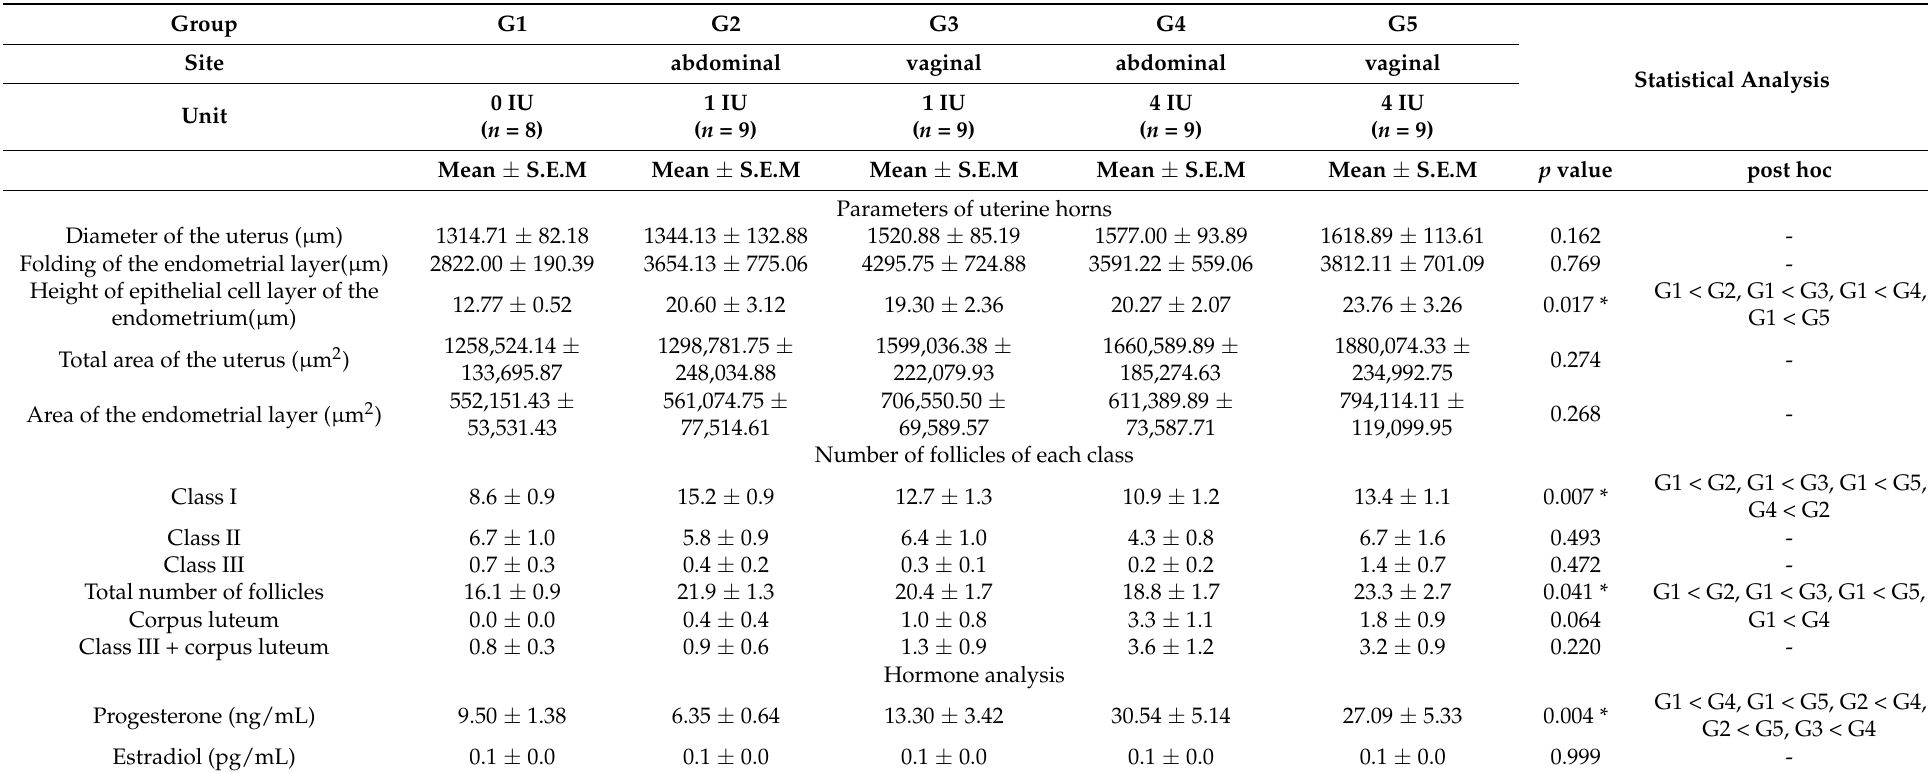
Table 3. Measurement of parameters of uterine horns, number of follicles classified, and hormone analysis in the rat